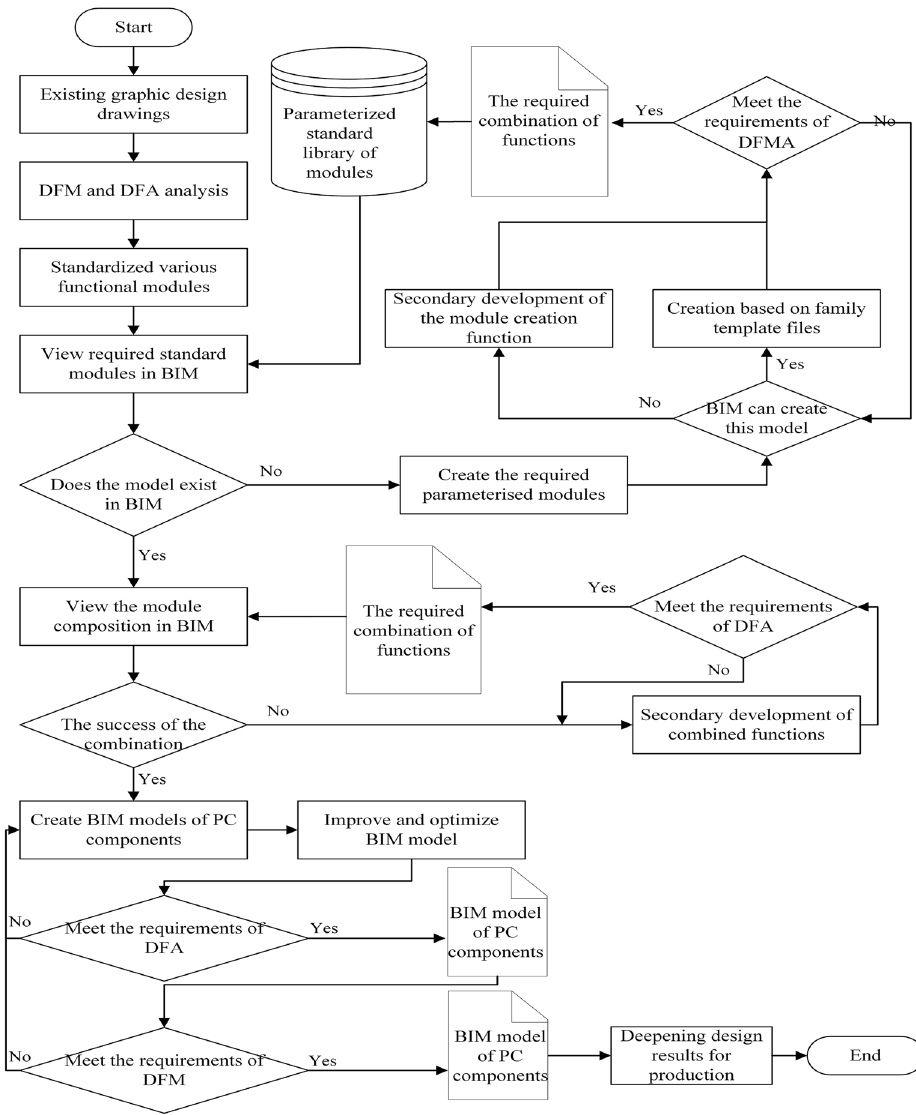
Figure 7. DFMA-based parametric design